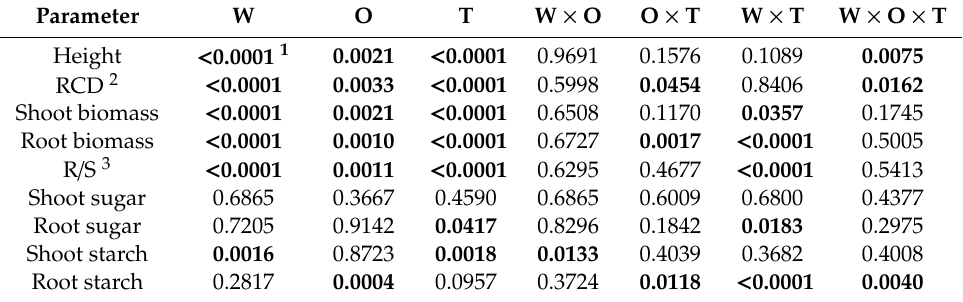
Table 1. p- values from mixed-model analysis of variance (ANOVA) of water availability (W), chitosan oligosaccharide addition (O), and sampling time (T) on growth, biomass accumulation, and carbohydrate content in Buddhist pine ( Podocarpus macrophyllus ) seedlings.